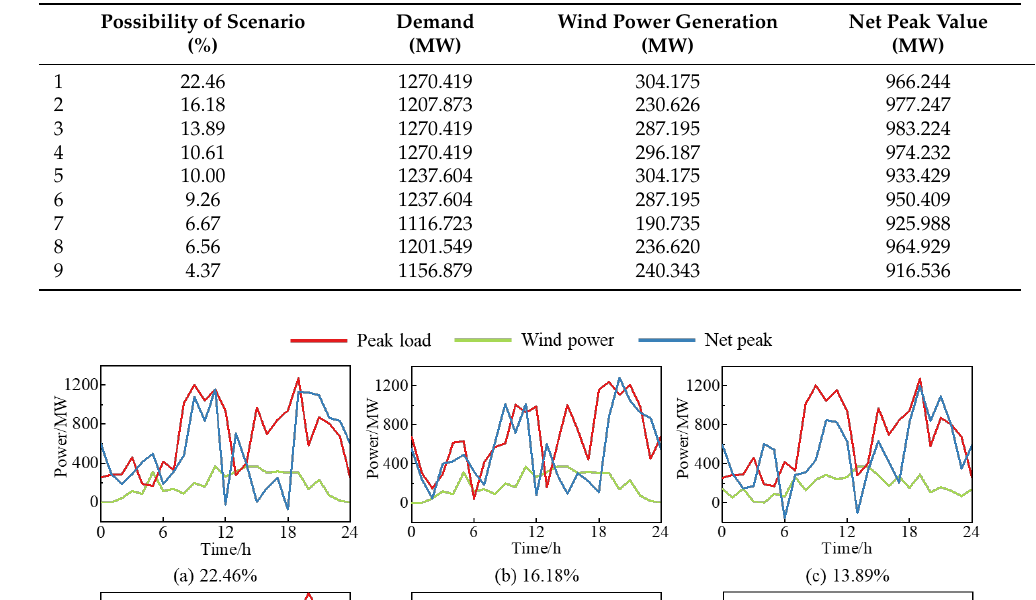
Table 3. Net load based on nine reduced scenarios.